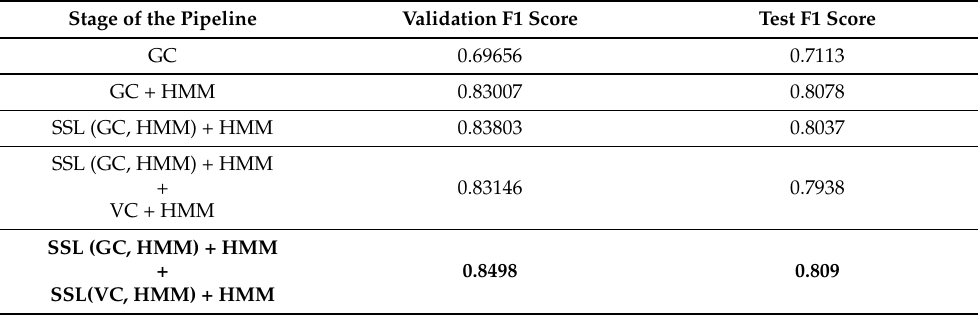
Table 12. A comparison of the F1 scores produced by different stages of the pipeline using a four-fold cross-validation scheme on the SHL-Validation set and on the official SHL-Test data. Abbreviations used in the table: GC—General classifier, HMM—Hidden Markov Model, SSL (X, HMM)—semi-supervised learning for classifier X, which uses the labels produced by the classifier X and an HMM tuned to that classifier to select instances for further training, VC—vehicle